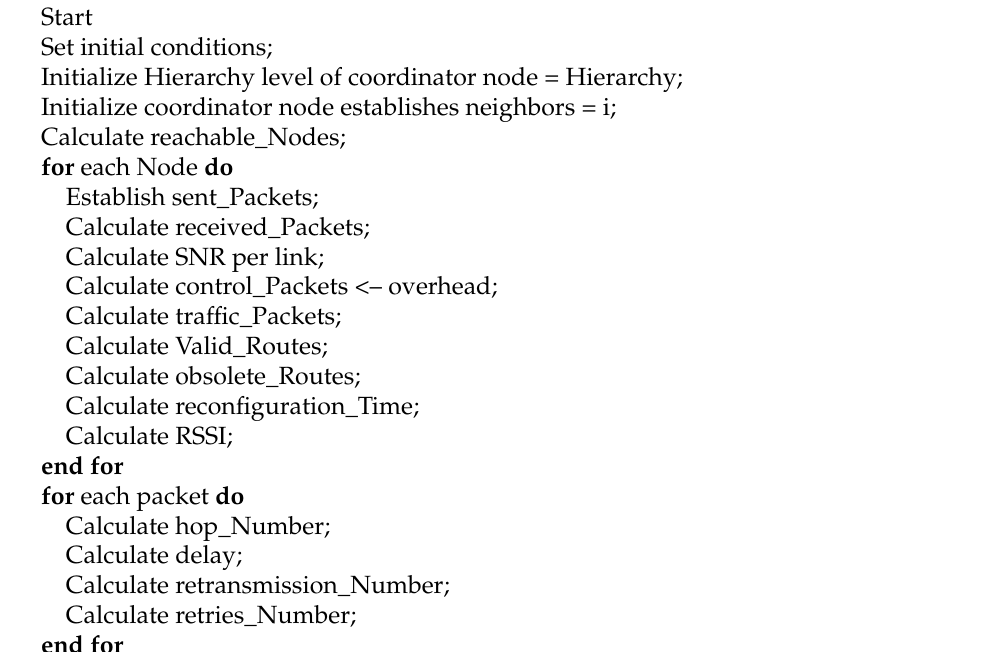
Algorithm 1 Computing of performance